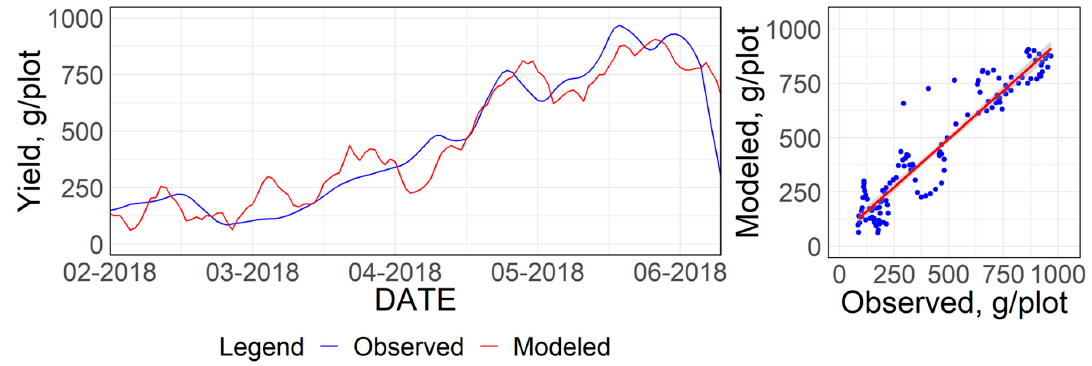
Figure 7. Multivariate regression model on the top six principal components on a weekly scale. ( Left ) Time series plot of observed and regressed crop yield. ( Right ) Observed vs. regressed values.